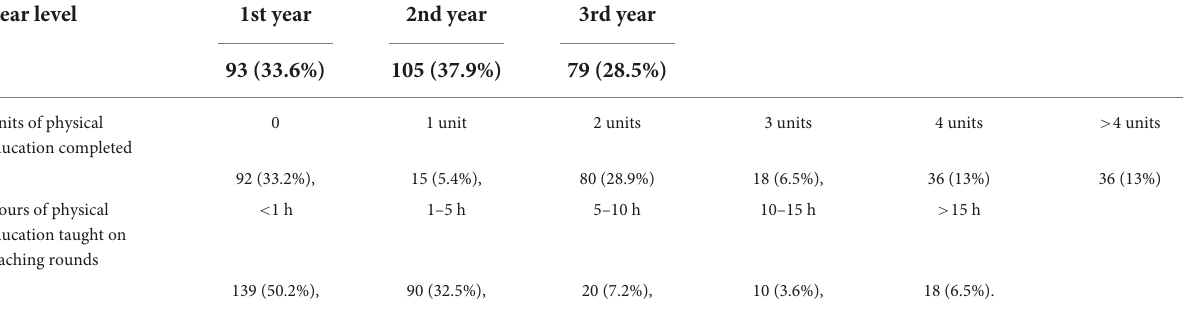
TABLE 1 Frequency and percentage of sample